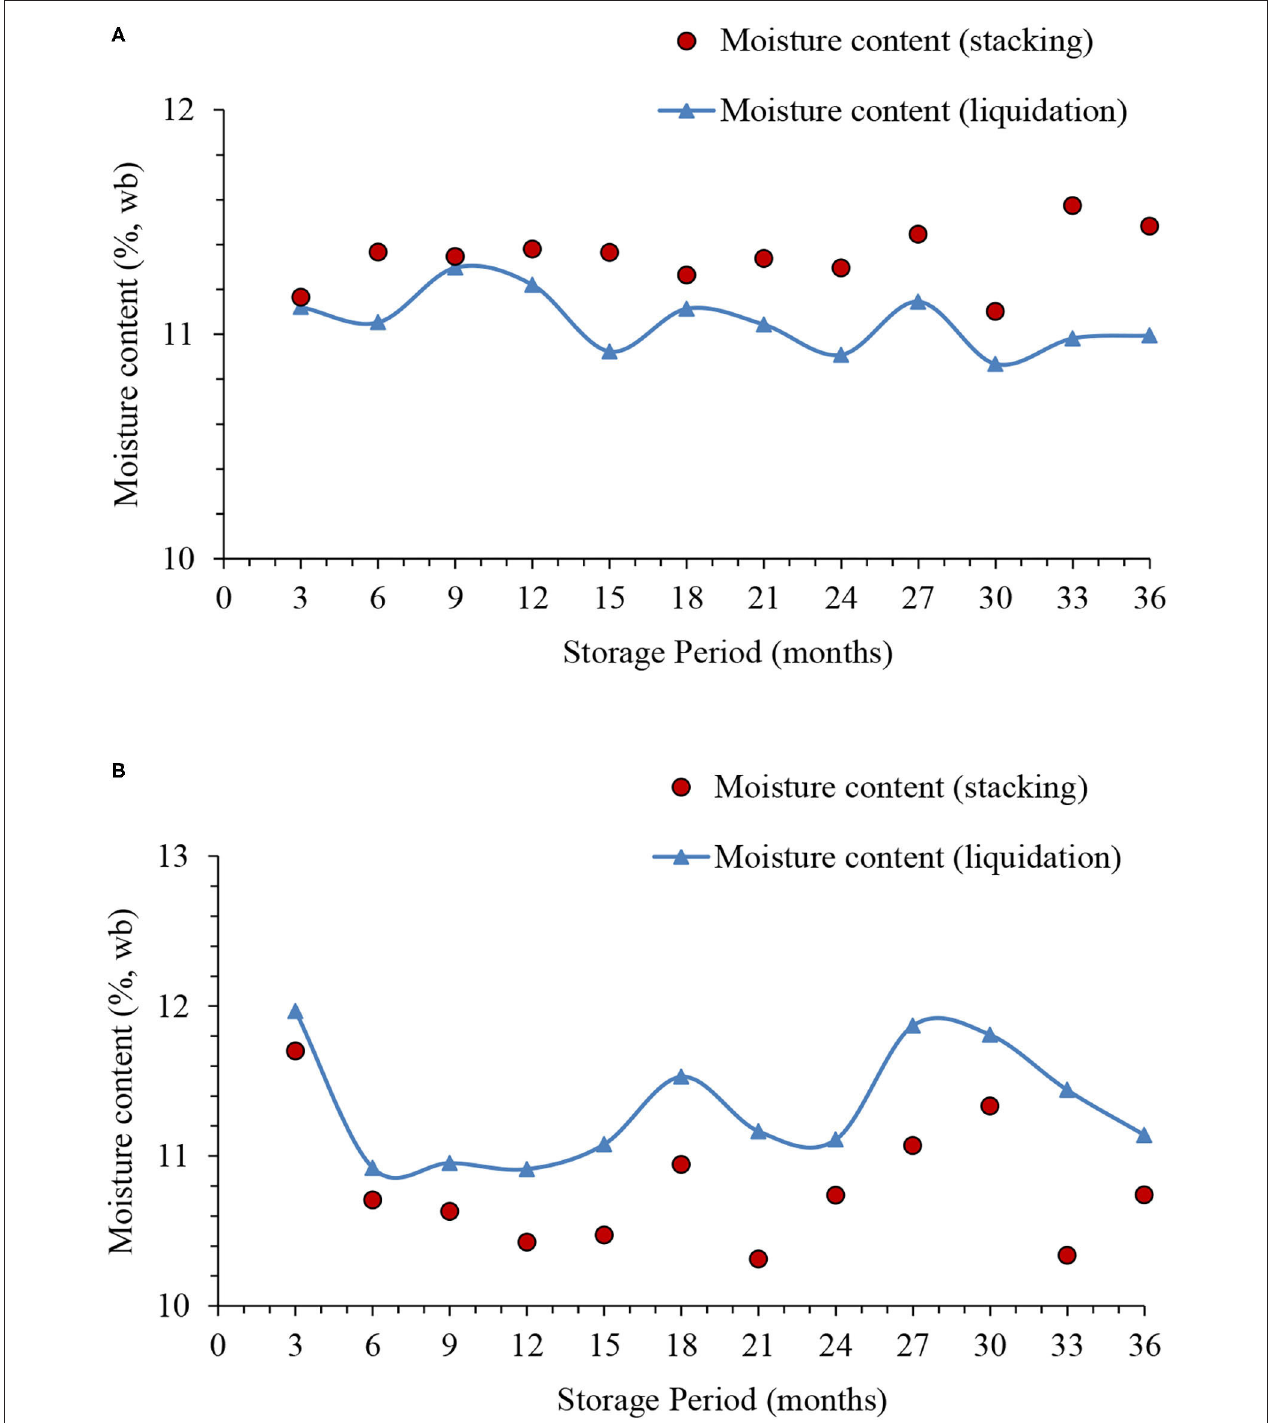
FIGURE 7 | Change in moisture content of wheat with storage period (A) consuming regions and (B) procuring regions.